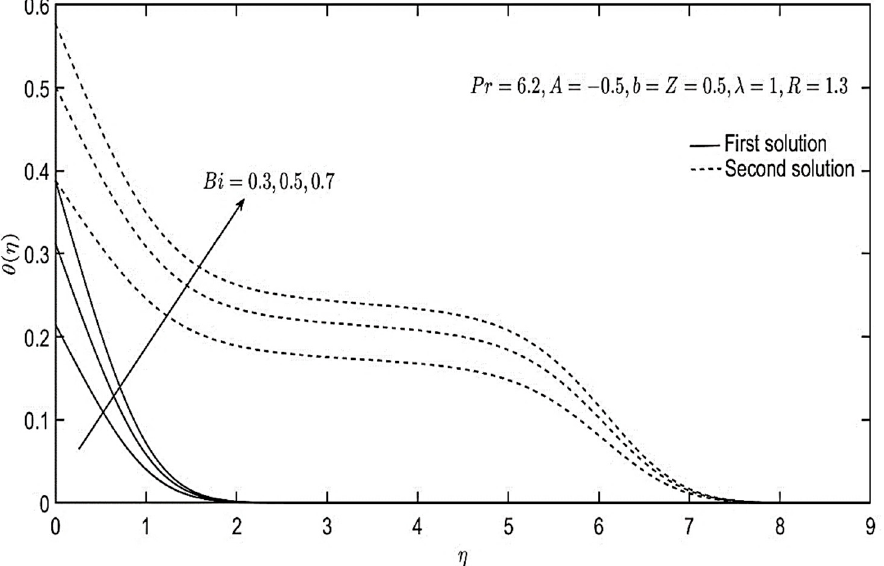
Figure 9. Temperature distributions for various values of 𝐵𝑖 .